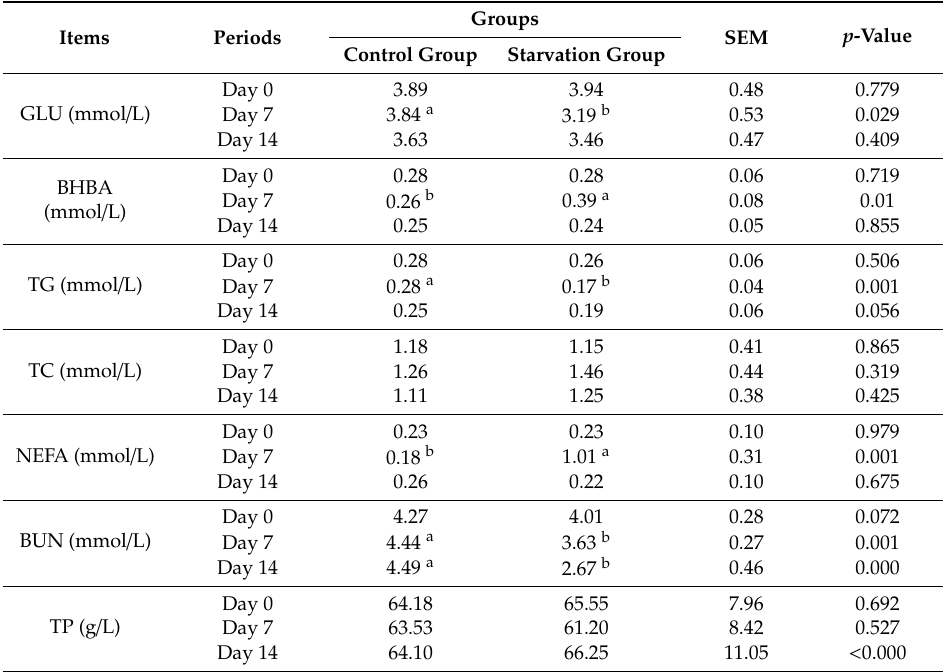
Table 2. E ff ects of starvation and refeeding on the blood biochemical indices of yak. Table 2. Effects of starvation and refeeding on the blood biochemical indices of yak. Groups Items Periods Items Periods SEM p -Value Control Group